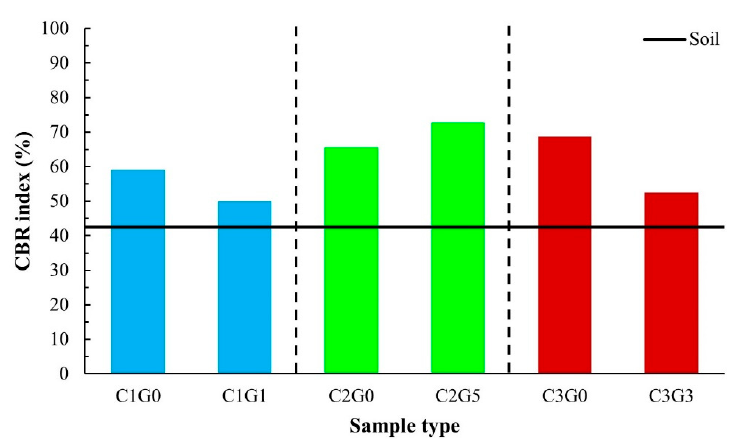
Figure 13. CBR indexes of the target mix in this study.